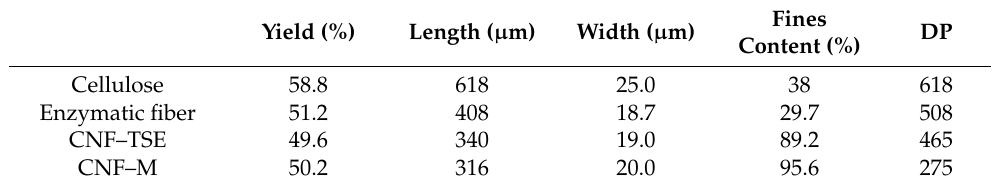
Table 1. Length, width fine contents, and DP of the obtained fibers from